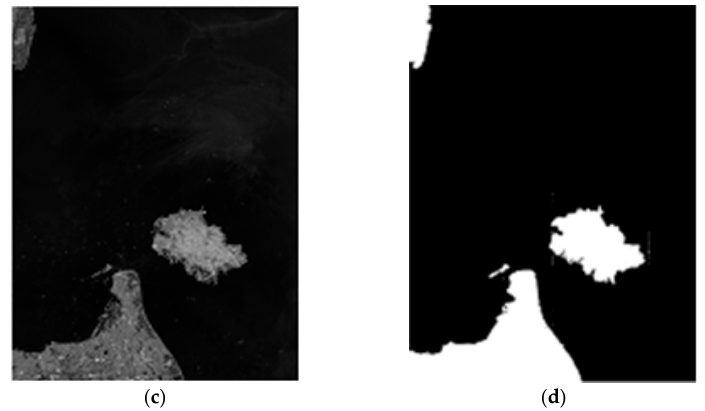
Figure 9. Sea-land segmentation results of the proposed method. ( a , b ) are Image #1 and the land masking result corresponding to it; ( c , d ) are Image #2 and the land masking result corresponding to it. Table 5. Comparison of land masking results of various methods on Image #1.